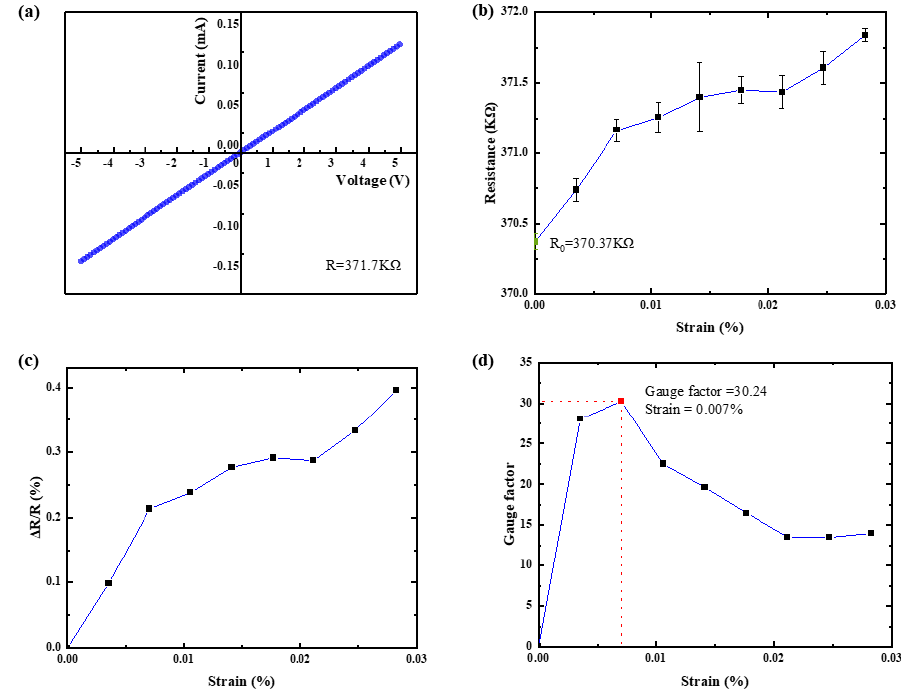
Figure 6. ( a ) I–V curve variation of CB/PVA composite with various loads evaluated using the four-point bending setup. ( b ) The change of film resistance under different strains. ( c ) The relative resistance change rates of the film under different strains. ( d ) The gauge factor of the CB/PVA film under different strains.